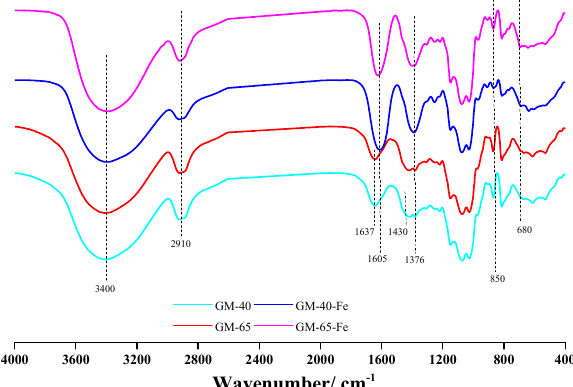
Figure 3. The FT-IR spectra of galactomannan and galactomannan – iron(III) complexes.